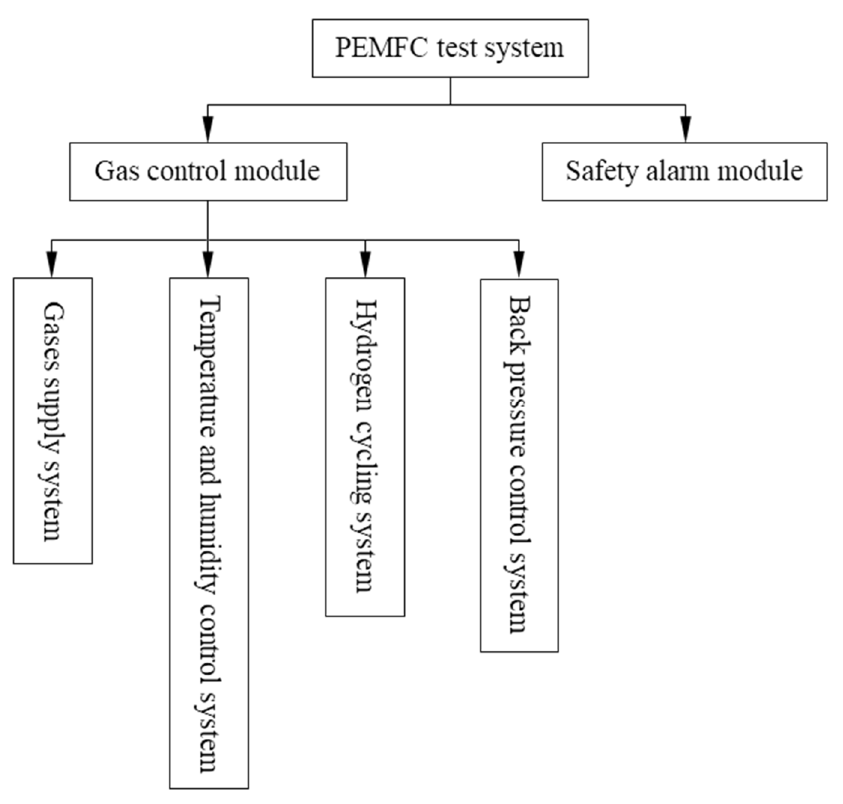
Figure 1. Basic composition diagram of the PEMFC test system.